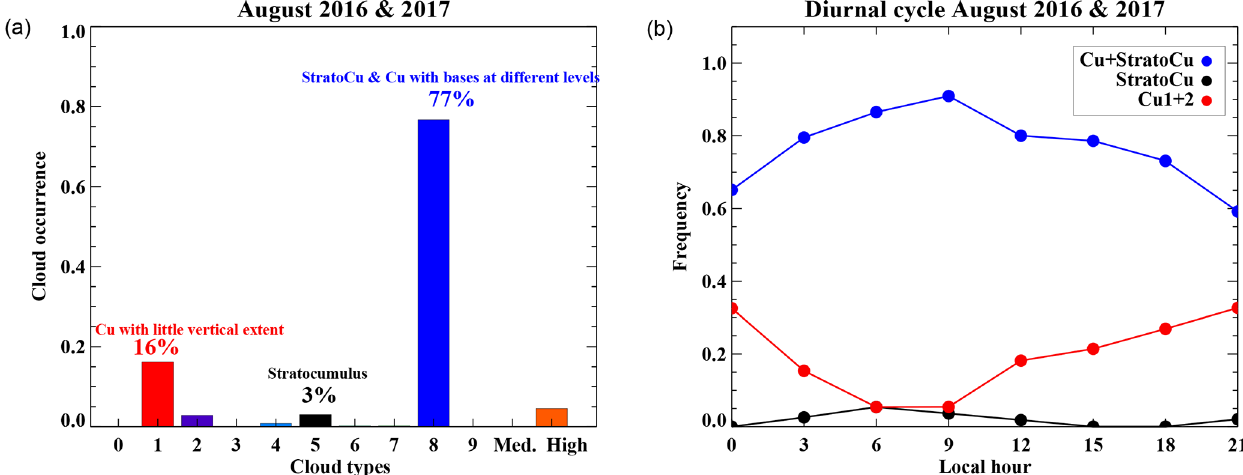
Figure 3. (a) Frequency of occurrence of the 3-hourly cloud types reported by surface observers for both August months, and (b) the corresponding diurnal cycle of the dominant low-cloud types. The cloud types are reported following World Meteorological Organization protocol: C L = 1,2 (red) represents “cumulus with little vertical extent” and “cumulus with moderate or strong vertical extent”, C L = 5 (black) represents “stratocumulus”, and C L = 8 (blue) represents “stratocumulus and cumulus with bases at different